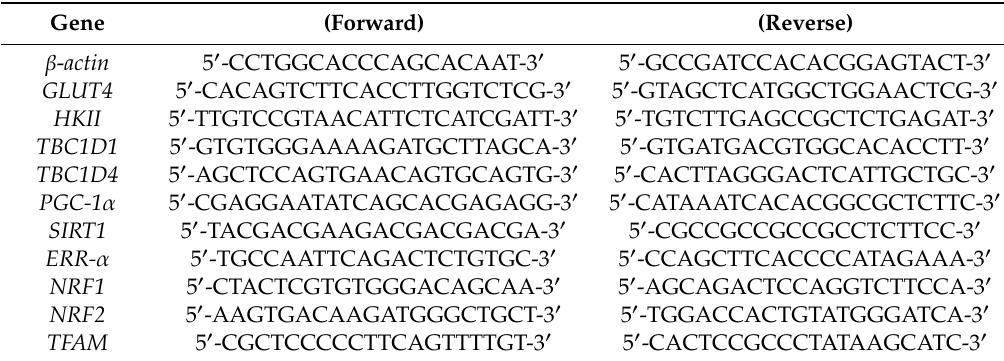
Table 1. Primer pairs used for